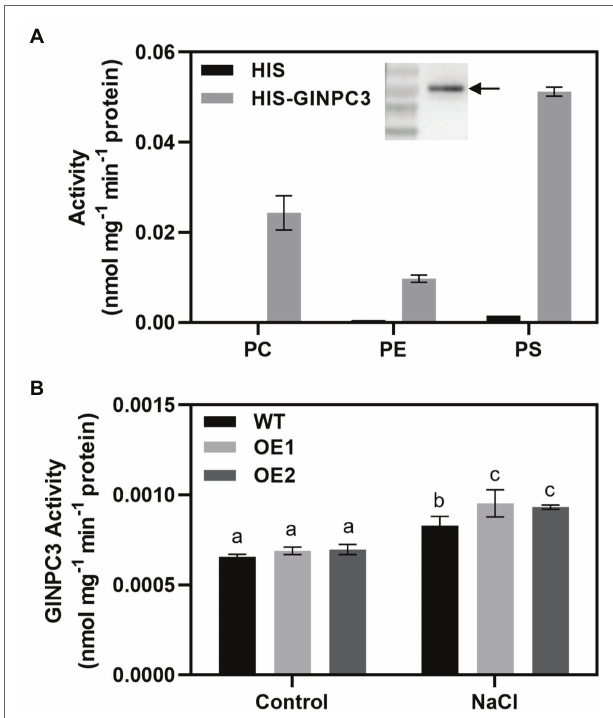
FIGURE 6 | GlNPC3 activity assay in vitro . (A) His-GlNPC3 activity assay in the presence of different fluorescent head-group-labeled lipid substrates. Data are mean ± SD of three measurements. Inset, immunoblotting assay of His-GlNPC3 fusion protein with the His antibody. Arrow indicates the protein. (B) Total non-specific phospholipase C (NPC) activities of WT and transgenic A. thaliana . Total protein was extracted from A. thaliana seedlings exposed or not to 75 mM NaCl for 24 days. Fluorescent head group-labeled phosphotidylserine (PS; 200 μ M) was used as the substrate. Data represent means ± SD three biological replicates. Different letters above each bar indicate significant differences ( p < 0.05, Duncan’s multiple range